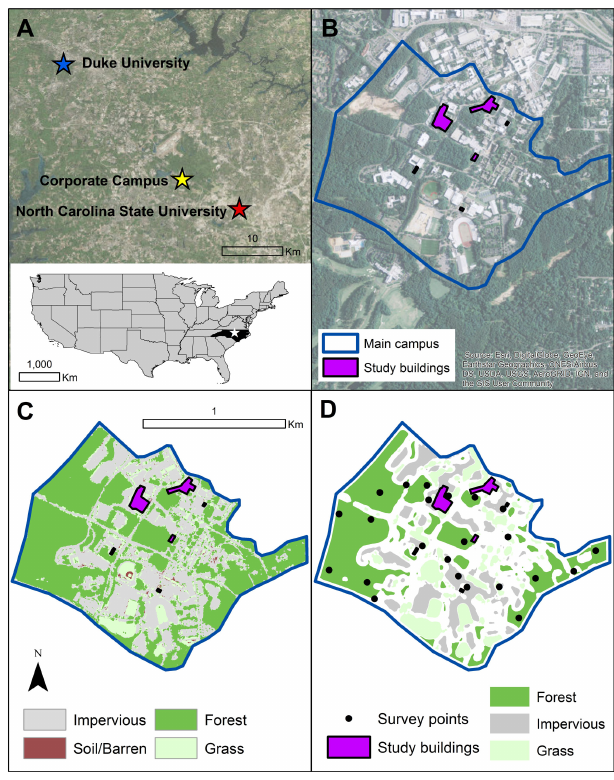
Fig. 1 . (A) Sites for bird window collision study in the Triangle region of North Carolina, (B) Duke University study site with sampled buildings highlighted, (C) 1-m resolution EPA land cover (US EPA 2013), (D) survey points over aerial